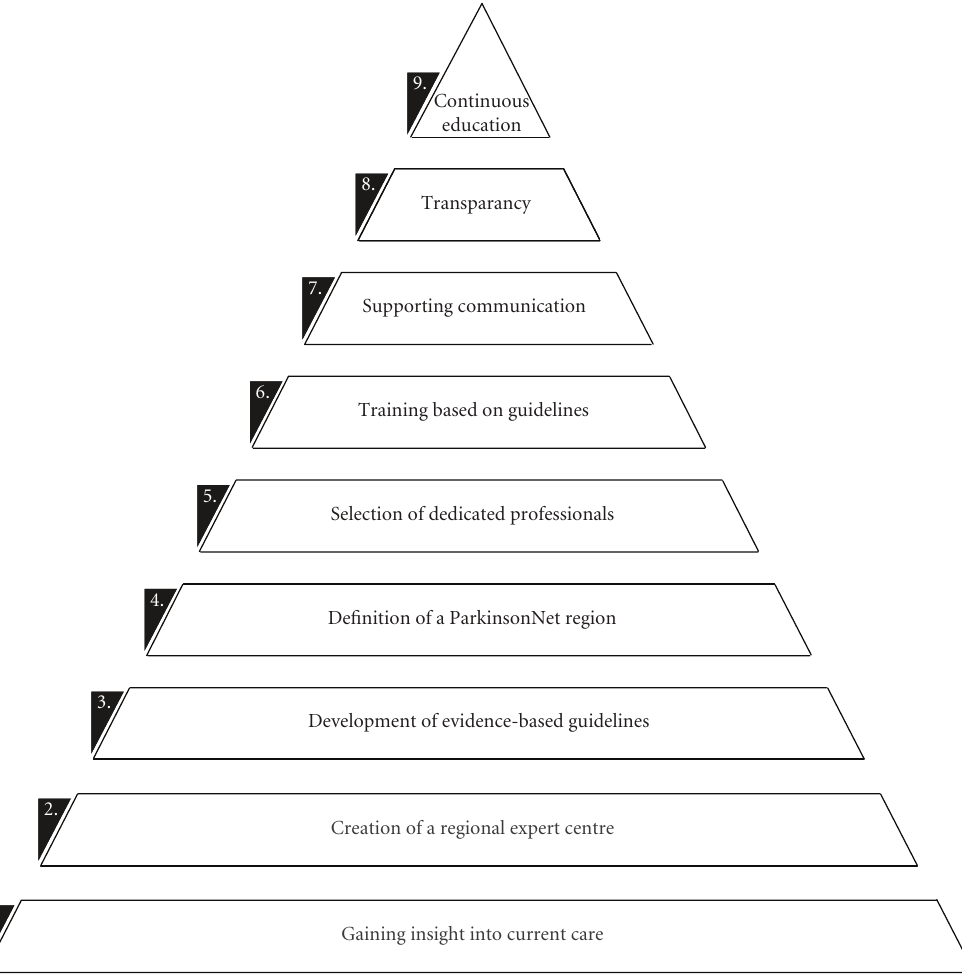
Figure 1: Steps of the Dutch model to improve community healthcare for Parkinson’s